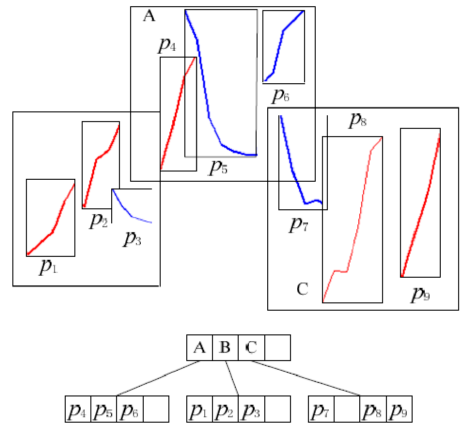
Figure 5. R-tree structure for indexing candidate patterns.